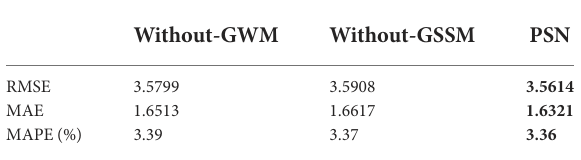
TABLE 8 PEMS08-60